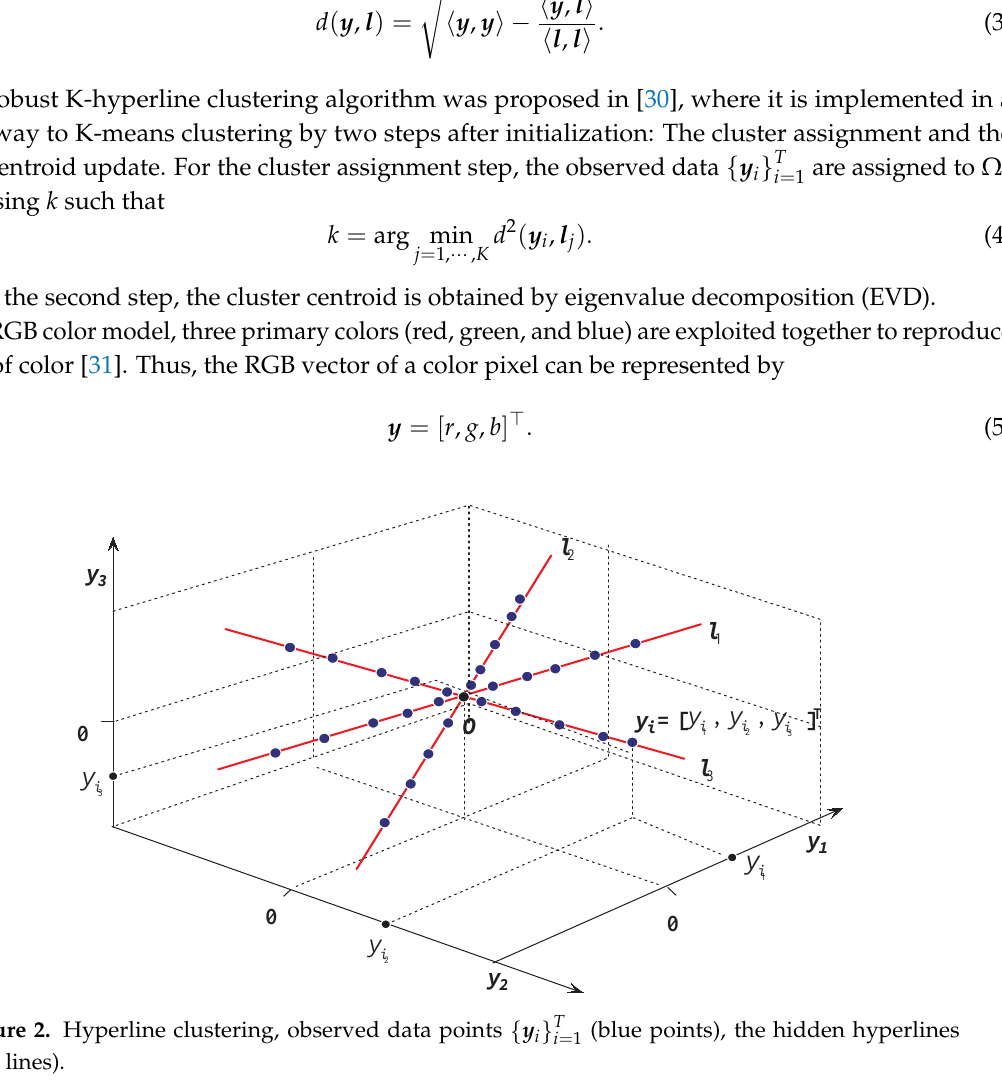
(blue points), the hidden hyperlines i = 1